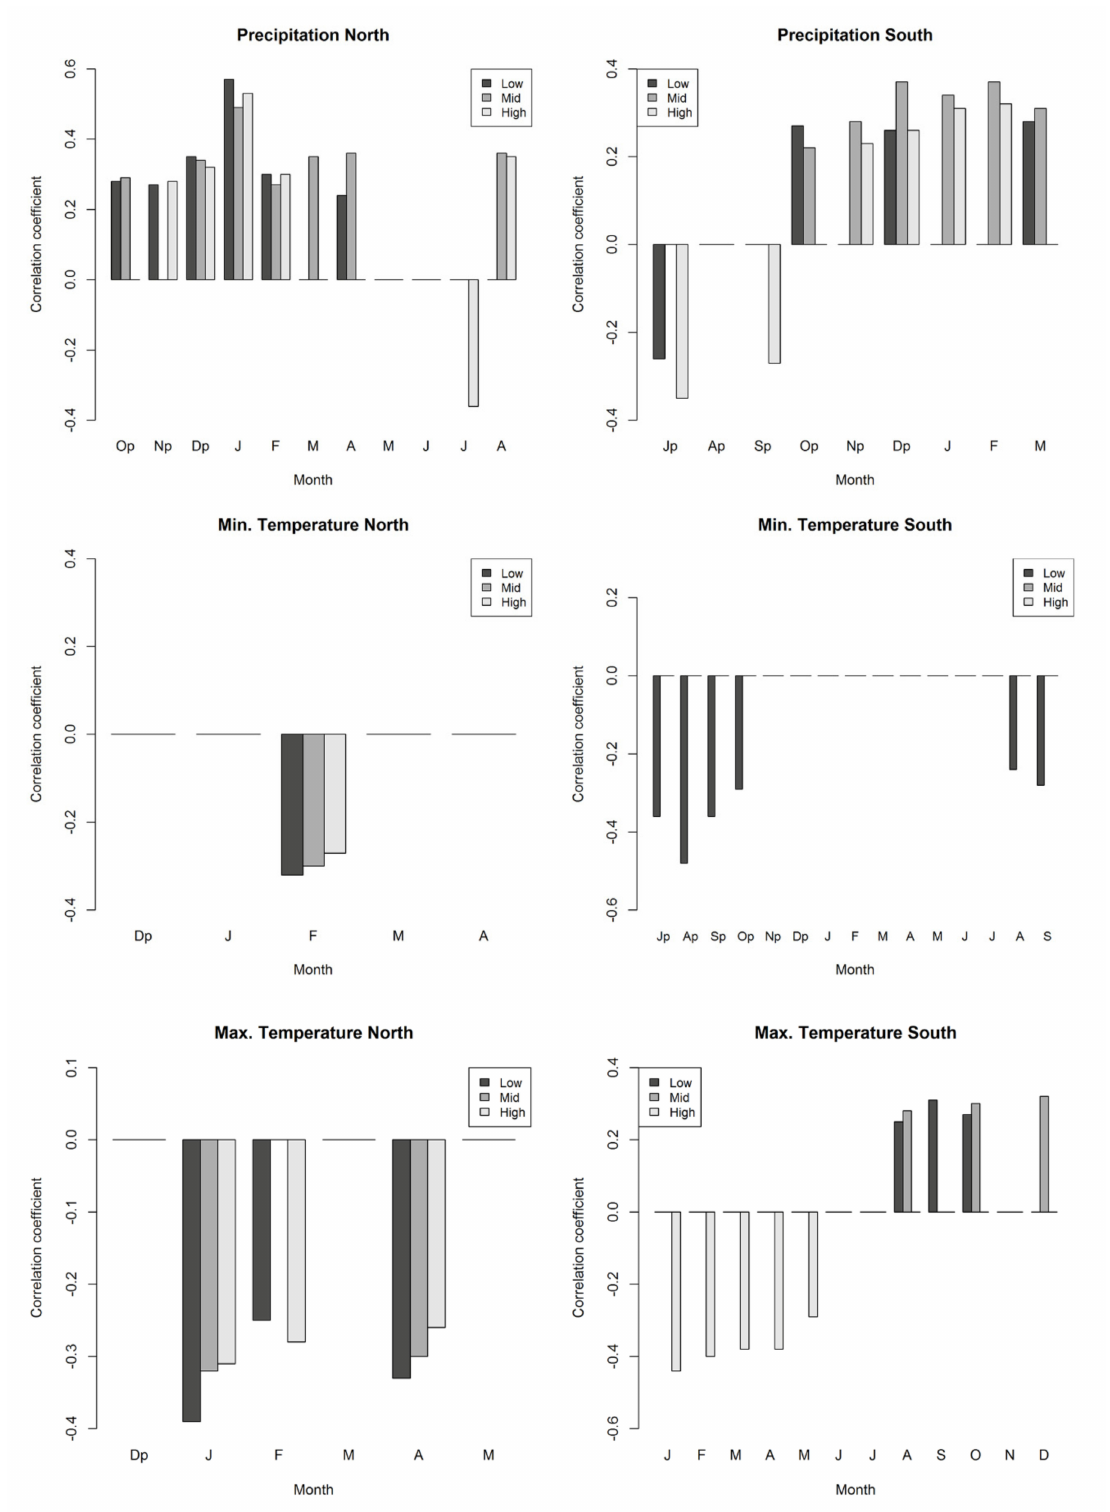
Figure 5. Correlation coefficients between tree-ring width and mean monthly climatic variables (precipitation, minimum temperature, and maximum temperature). All values shown are statistically significant ( p < 0.05), Dendroclim only shows significant values. Capital letters are months initials. The letter “ p ” next to some month initials denotes